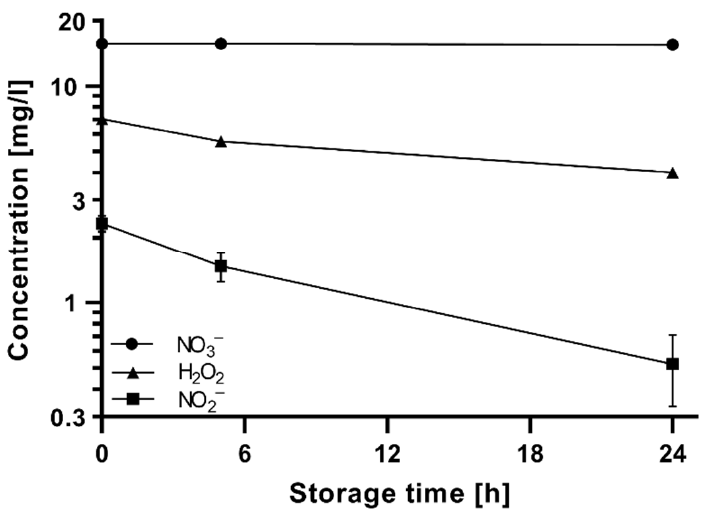
Figure 5. Variation of nitrate (NO 3 − , mg/L), hydrogen peroxide (H 2 O 2 , mg/L) and nitrite (NO 2 − , mg/L) concentrations in PAW at 5 h and 24 h after plasma treatment. One-way ANOVA, p < 0.05.